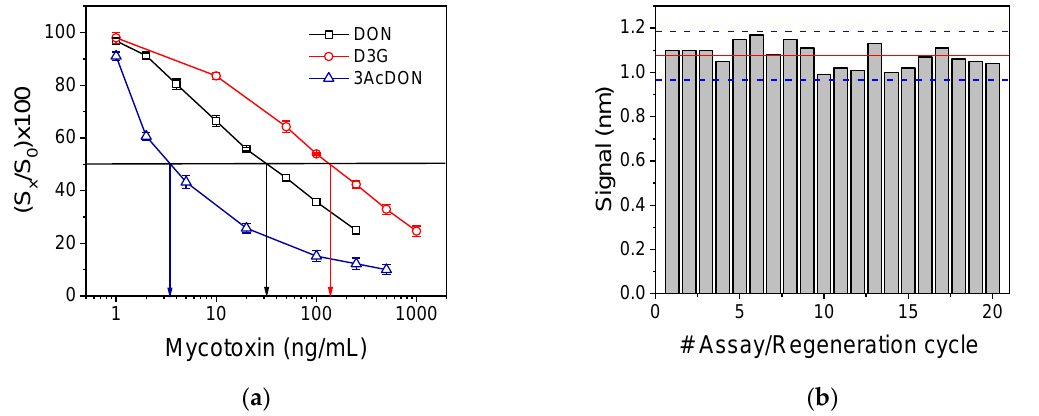
Figure 6. ( a ) Calibration curves obtained for DON (open squares), 3-DON-glycoside (open circles), and 3-acetyl-DON (open triangles) using chips coated with DON-OVA. The horizontal to x -axis black line corresponds to (S x / S 0 ) value of 50%, whereas the vertical to x -axis blue, black, and red lines indicate the mycotoxin concentration that corresponds to 50% (S x / S 0 ) for each one of the respective calibration curves. ( b ) Zero calibrator signals obtained from a single chip upon repetitive assay / regeneration cycles. The red solid line indicates the mean value of the 20 measurements and the blue dashed lines the ± 2SD limits. Each point is the mean value of 3 measurements ± SD.